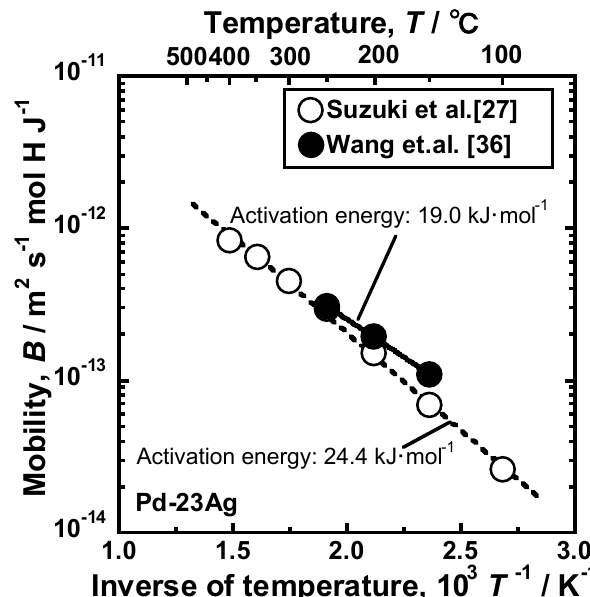
Figure 11. Arrhenius plot of the mobility ( B ) for hydrogen diffusion in Pd–23 mol%Ag alloy [27]. The intrinsic hydrogen diffusion coefficients reported by Wang et al. [39] are modified into the mobility for hydrogen diffusion and plotted in the figure, with copyright permission from Japan Institute of Metal and Materials